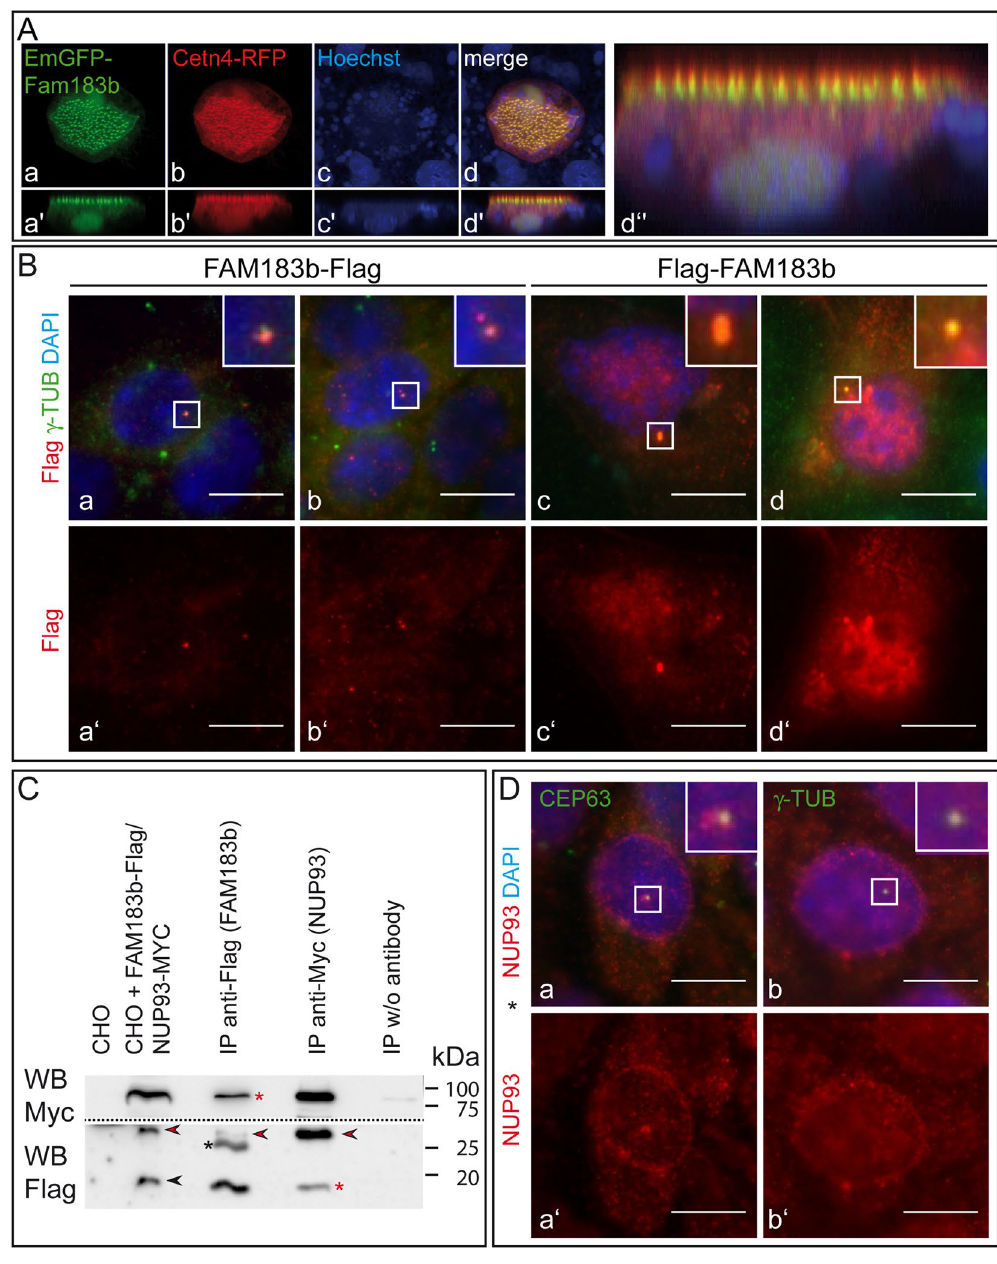
Figure 2. Subcellular localisation of FAM183B. ( A ) Co-localisation of mouse FAM183b-GFP with centrin4 in stage 33 Xenopus embryos. ( B ) Detection of C- and N-terminally Flag-tagged FAM183b in mIMCD3 cells by indirect immunofluorescence showing partial overlap with γ -tubulin. ( C ) Co-IP of tagged FAM183b and NUP93, indicating interaction. Red asterisks: co-IP; black asterisk: anti-Flag light chain detected by secondary antibody; black arrowhead: FAM183b at the expected apparent molecular weight; red arrowheads: background band detected in transfected CHO cells and IPs. Full size Western blots are shown in Supplementary Figure S2. ( D ) Co-localisation of endogenous NUP93 with CEP63 and γ -tubulin at centrosomes. Scale bars: Ba–d,a’–d’, Da,b,a’,b’ = 10 μ